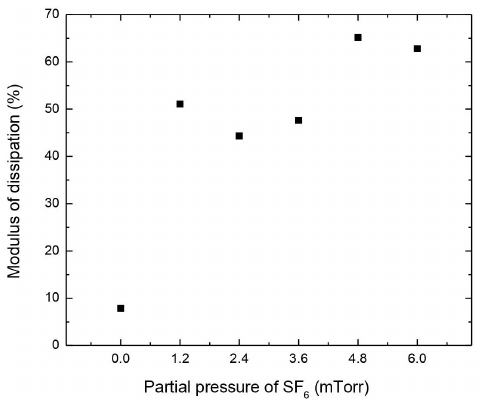
Figure 19. Modulus of dissipation as a function of R depicted in Figure 19 . All the fluorinated films (R show moduli of dissipation of about 45 to 65%, compared to < 10% for the unfluorinated film.